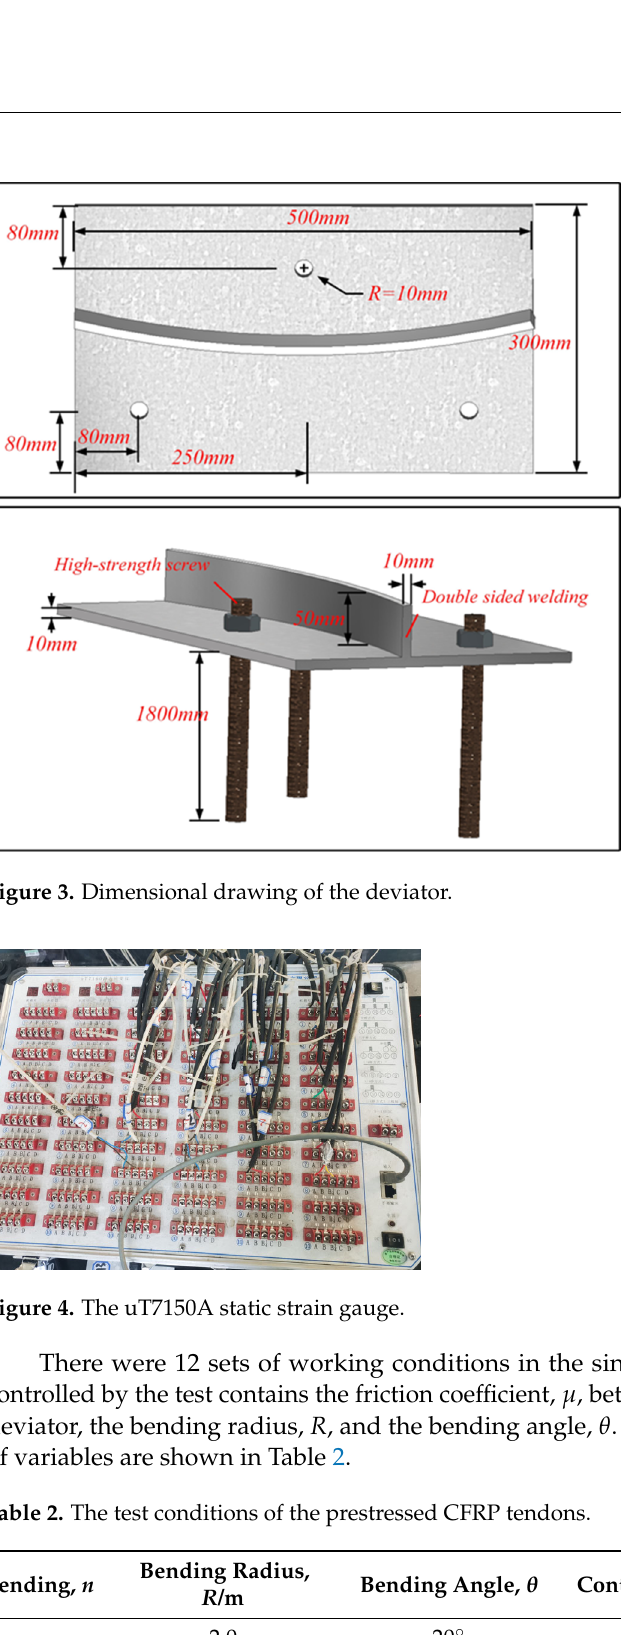
Figure 4. The uT7150A static strain gauge.